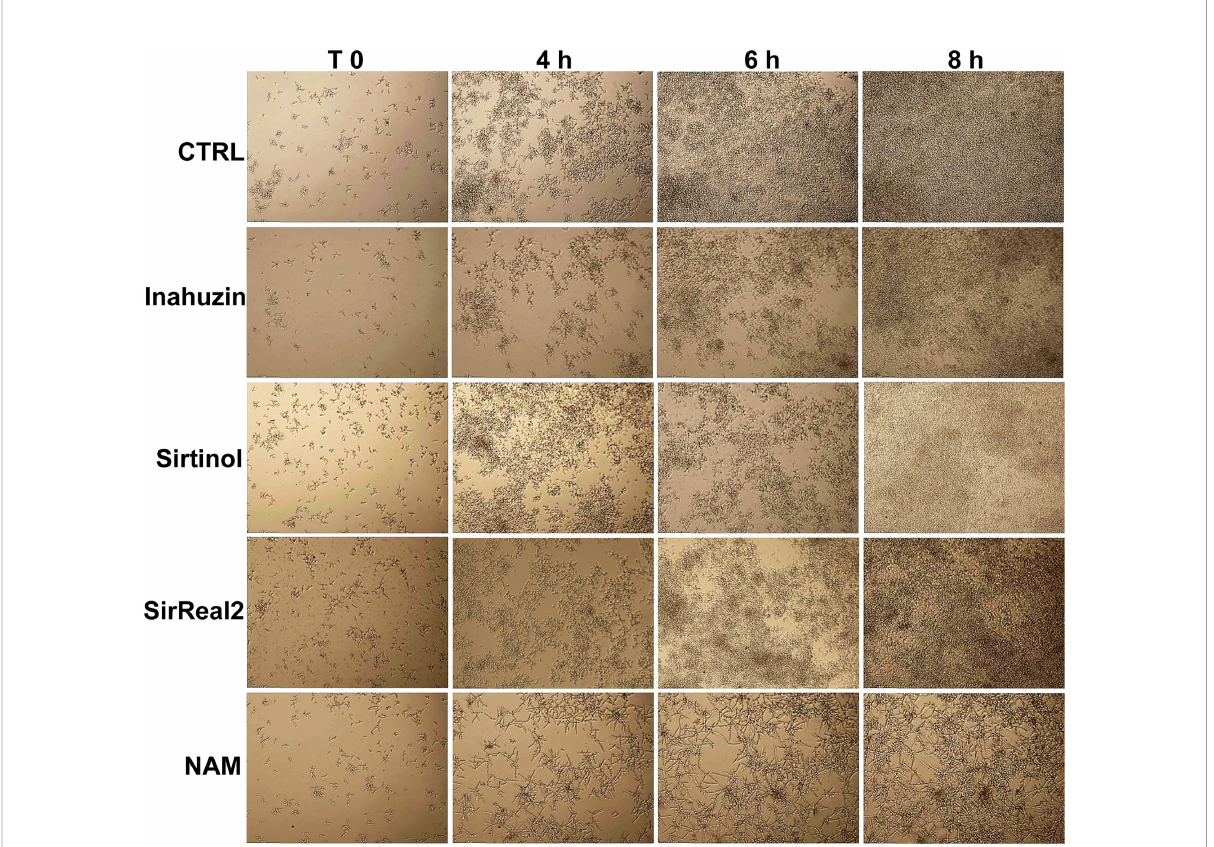
FIGURE 3 Morphological analysis of C. albicans in the presence of sirtuin inhibitors. C. albicans cells were treated with 50 µM Inauzhin, 10 µM Sirtinol, 50 µM SirReal2, or 10 mM NAM, and the morphology was imaged by Time-Lapse microscopy (10X magni fi cation). Sirtinol, SirReal2, and Inauzhin do not inhibit Hst3p as they do not alter yeast